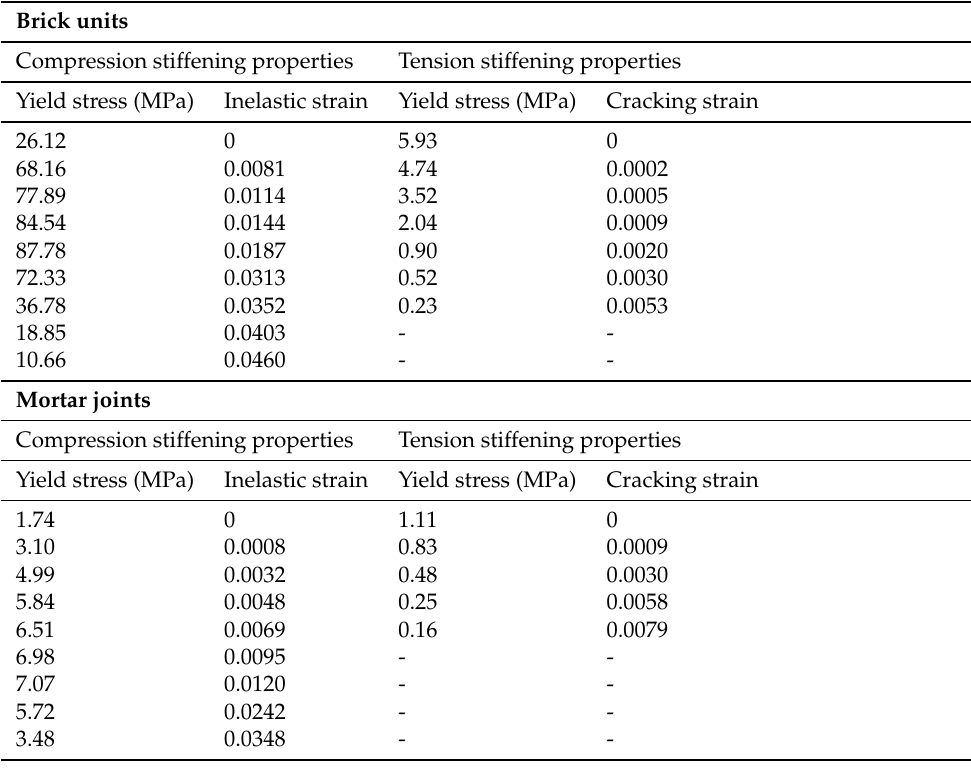
Table 1. Yield stress and corresponding strain values of brick units and mortar joints